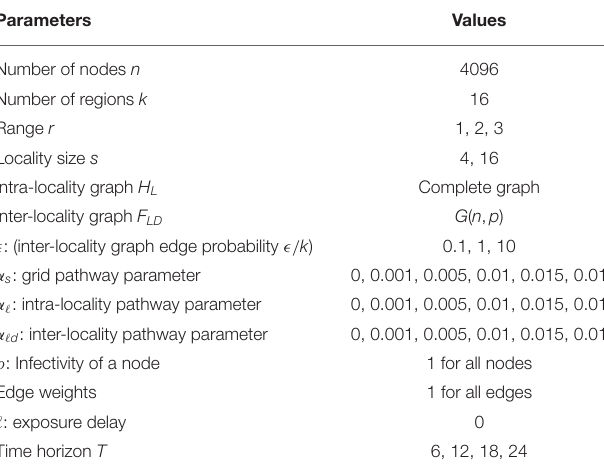
TABLE 3 | List of network and SPREAD model parameters used in the experiments for the MPSN model.